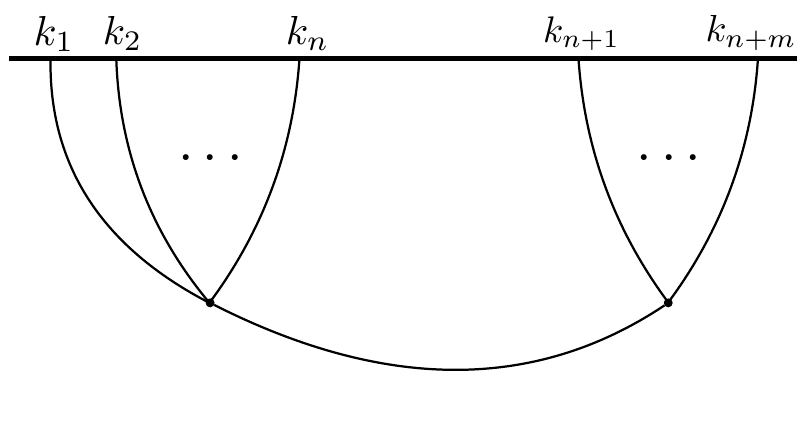
Figure 2. Single exchange diagram for n + m external